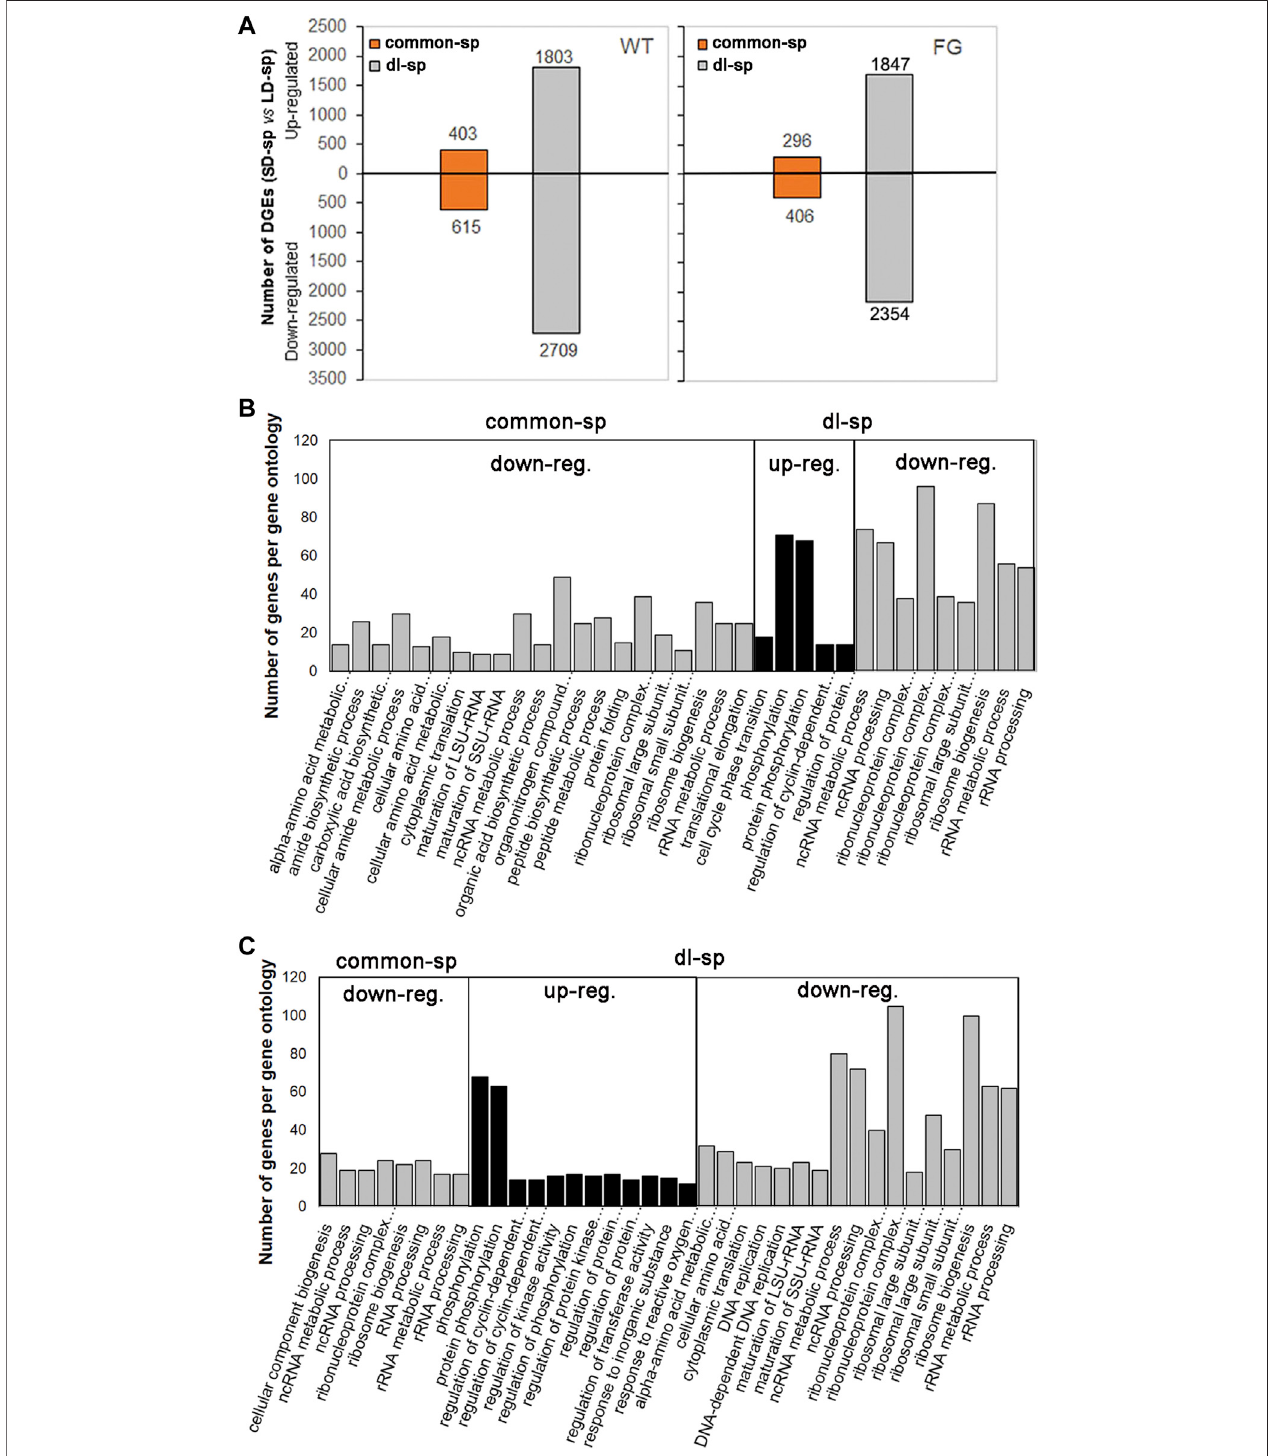
FIGURE6| Pair-wisecomparisonandGOtermsanalysisofchangesinspace fl ight-affectedgeneexpression. (A) Differentialexpressiongenes(DEGs)undertheLDandthe SDinspace(sp)withsimilarbehaviorsastheircontrolsontheground(gr)underthesameconditions(-1 < log 2 FC(SD-sp/grvsLD-sp/gr) < 1)areputthe ‘ common-sp ’ group.DEGs undertheSDinspincomparisonwiththeirgrcontrolsexhibiteddifferentlevelsfromthoseundertheLDinspincomparisonwiththeirgrcontrolsunderthesamecondition(log 2 FC (SD-sp/grvsLD-sp/gr) > 1or < -1)areputthe ‘ daylength-spacerelated ’ (dl-sp)group.FC,foldchange. (B,C) GOtermsoverrepresentedDEGsinthe ‘ common-sp ’ andthe ‘ dl-sp ’ groups of WT (B) and FG (C) . The signi fi cant gene ontology (PANTHER statitical overrepresentation test, GO-Slim biological precess, FDR p -value < 0.01) categories from up-regulated(up-reg.)DEGsordown-regulated(down-reg.)DEGsinWTandFGundertheLDandtheSDaredepicted.WT,wild-type;FG, pHSP : FT ; pHSP : GFP trangenicplants.